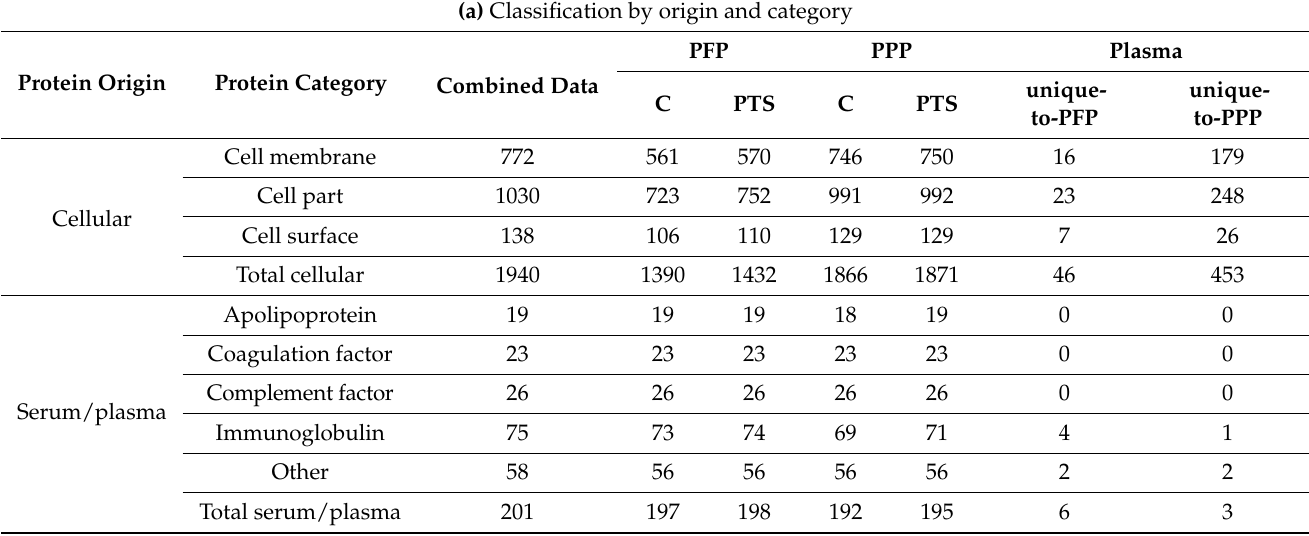
Figure 2. Extracted features from ZetaView ® nanoparticle size distributions for PFP (upper row) and PPP (lower row) samples. The samples are further separated by transport mode C (left boxes) or PTS (right boxes). From left to right the following features were extracted from the ZetaView ® size distribution: area under the curve (AUC), standard deviation of the particle size distribution, skewness of the size distribution, the size at maximum intensity, and the median particle size. The number above each boxplot is the p − value of the Welch’s t − test between the C and PTS values. Table 1. Number of protein groups quantified in all cEV isolates. (a) Classification by origin and